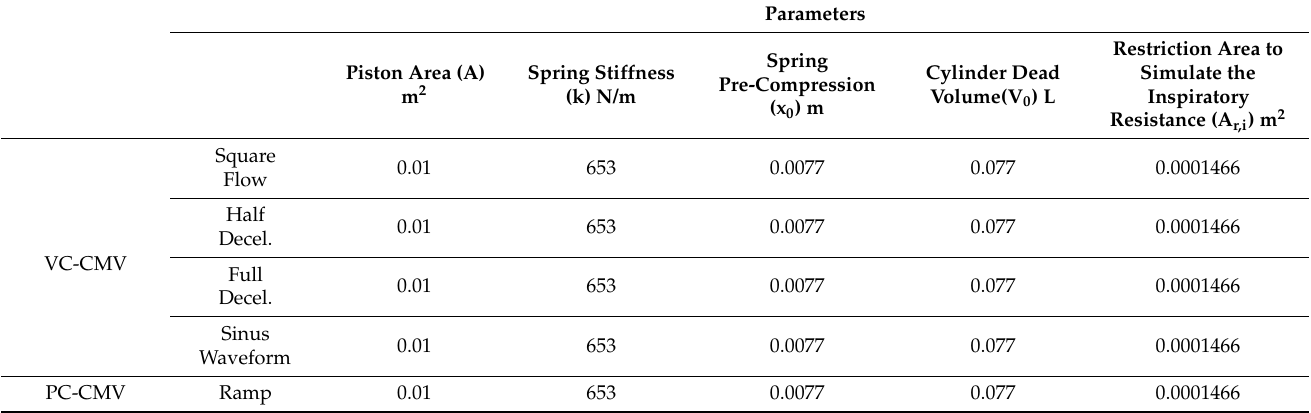
Table 7. Parameters set in the subroutine “Patient” concerning simulations of real-life cases of the Case 1.